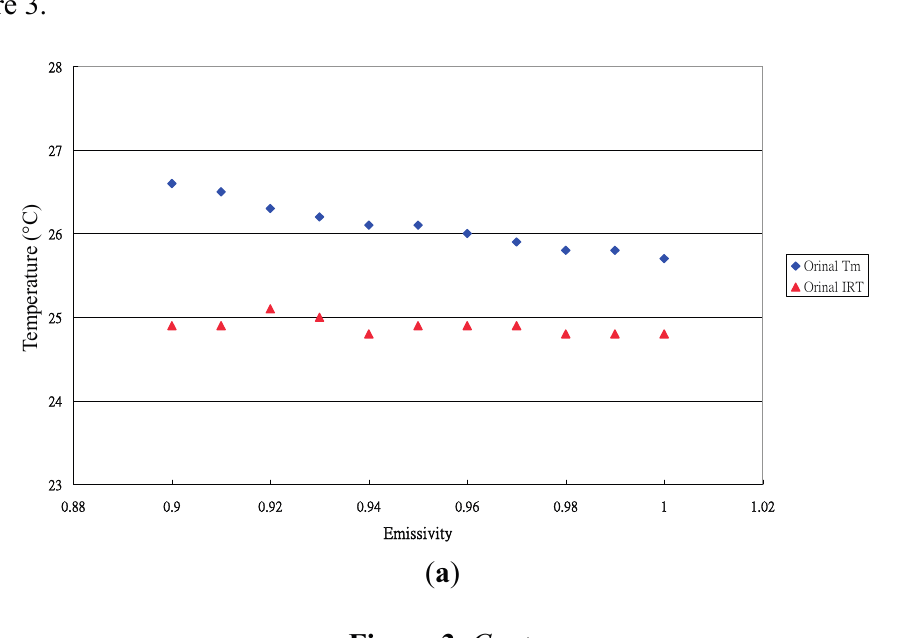
Figure 2. Typical data distribution for the ratio ( ) and